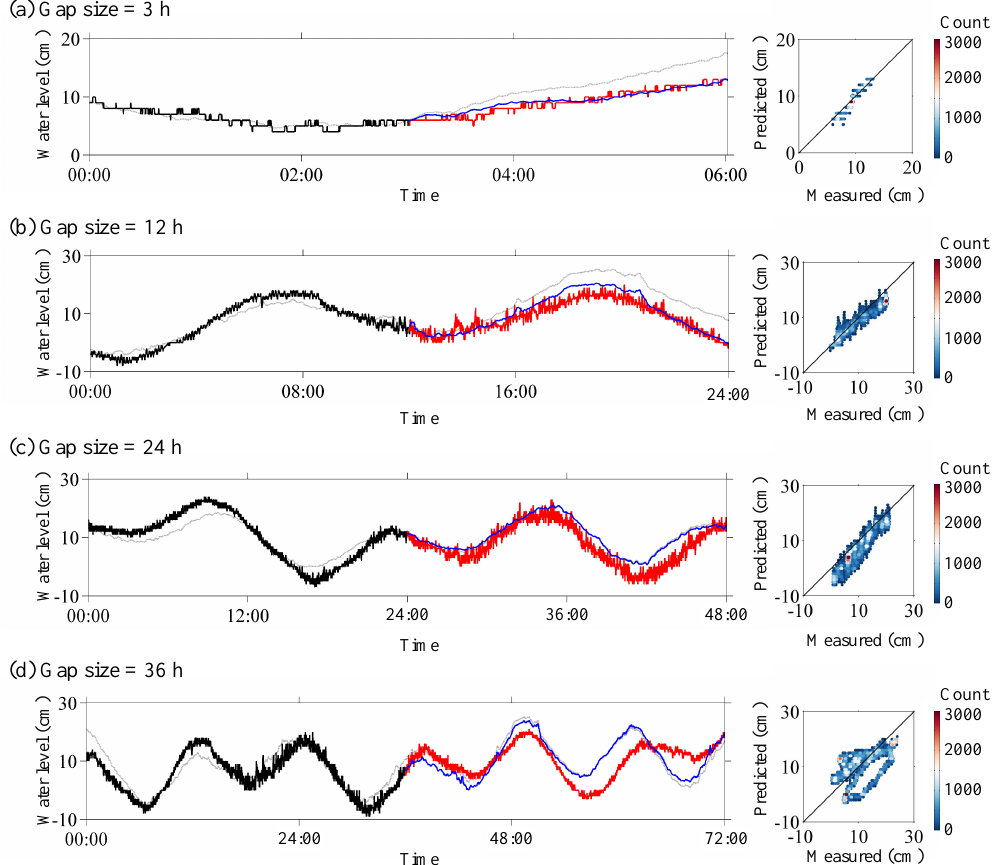
Figure 9. Examples of the gap-filling algorithm using the calibrated parameters when the gap sizes are (a) 3h, (b) 12h, (c) 24h, and (d) 36h. The left panel shows the time series. The black lines represent the target data, and the gray lines represent the data of the selected search window. Blue lines represent the SWEP data; Red lines represent the measured data that was intentionally omitted. The right panel shows the scatter plot between the predicted data (or the SWEP data) and the measured data. The color point represents the frequency of data plotted inside the circle with a radius of 1 cm.